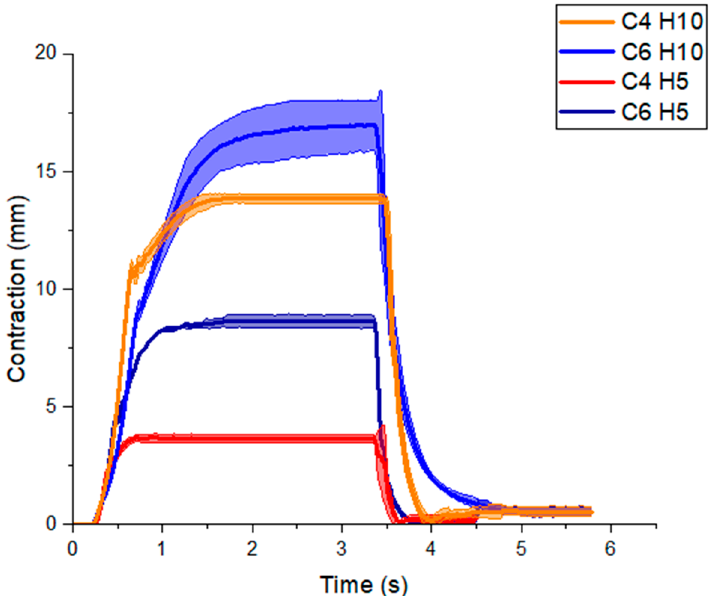
Figure 10. Dynamic response of actuator contraction. Displacement of unconstrained end of actuators with 4 and 6 cells (C4 and C6) and heights of 5 and 10 mm (H5 and H10) over time, given a step input of − 20 kPa vacuum pressure. A 200 g mass hanging from a string passing through a pulley is attached to the unconstrained end of the actuator, which is oriented horizontally.